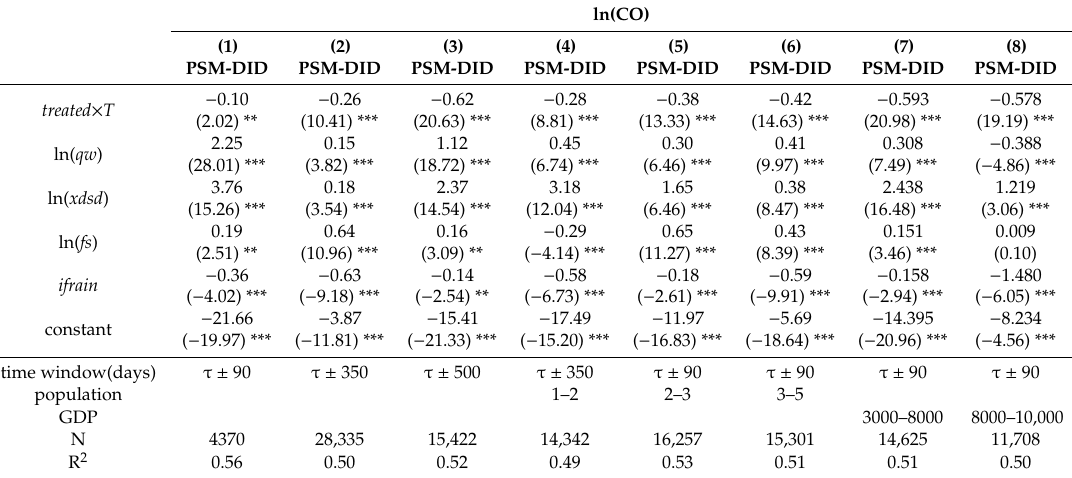
Table 10. The impact of the subway openings on